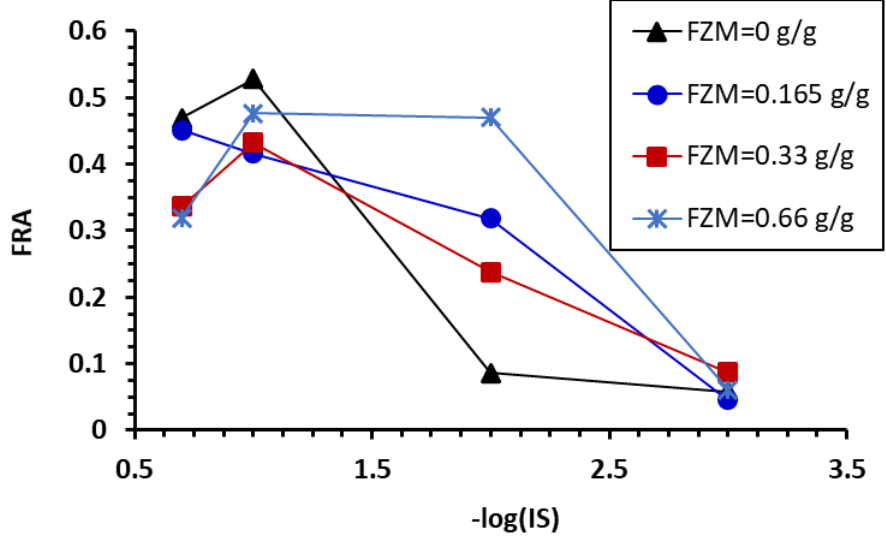
Figure 7. Calculated fraction of reversibly attached Mt and Mt-nZVI (FRA) as a function of solution IS at which the particles were attached in Phase A. FRA = M C /(1− M AB ), where M AB and M C are the fraction of colloids recovered from Phase A and B and Phase C, respectively.